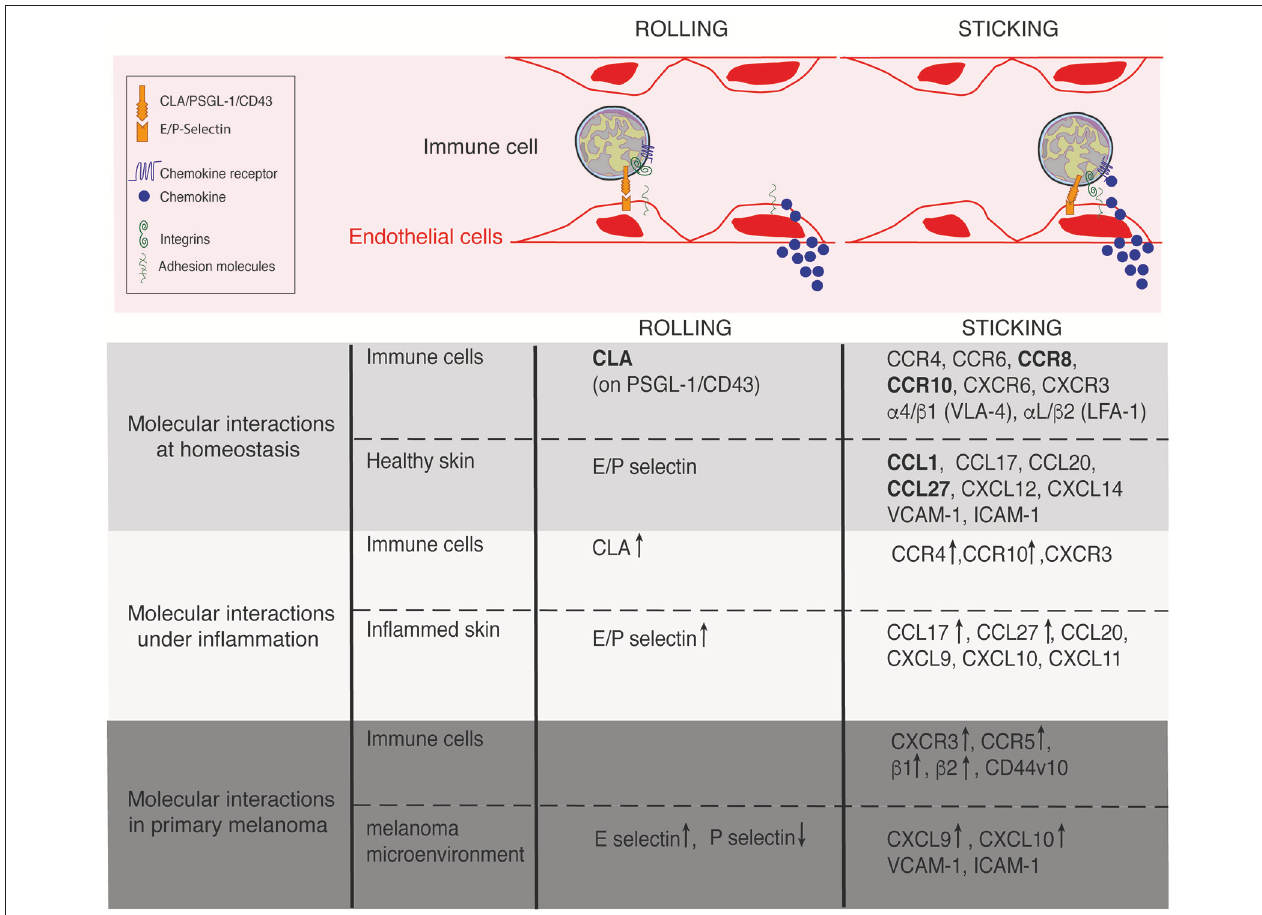
FIGURE 2 | Lymphocyte trafficking into the skin at homeostasis, under inflammation and in primary melanoma. Molecules involved in the rolling and sticking (firm adhesion) steps of lymphocytes recruitment at homeostasis, under inflammatory conditions and in primary melanoma are listed on the figure. Of interest, most of the molecules are shared between conditions. ↑ and ↓ indicate up- and down- regulated expression, respectively in comparison to homeostasis. Skin-specific molecules are in bolt.